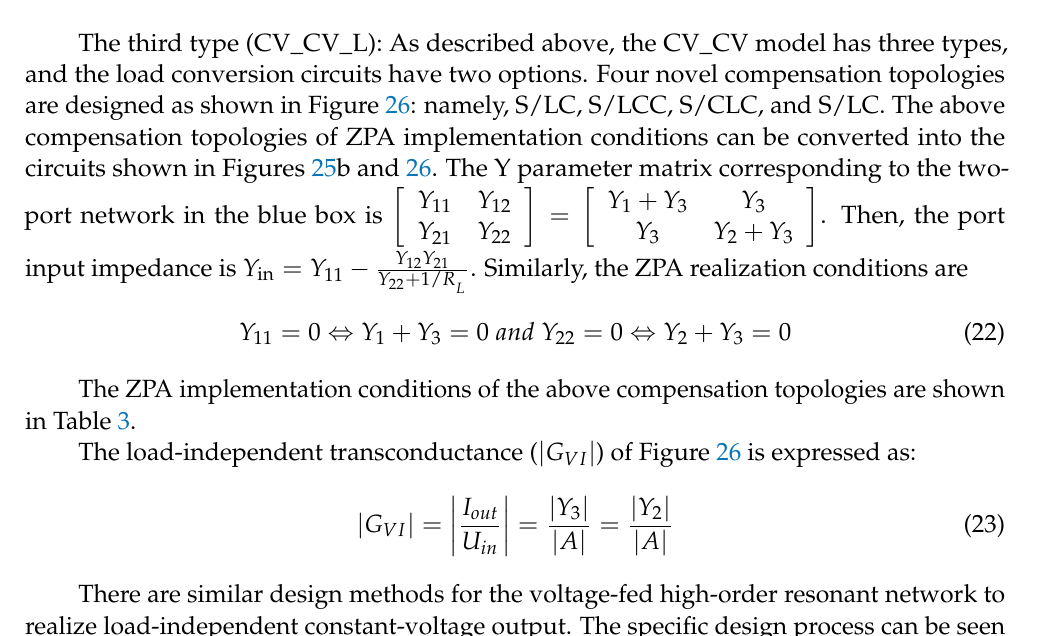
Figure 26. The CV_CV_L compensation topologies: ( a ) S/LC; ( b ) S/LCC; ( c ) S/CLC; ( d )